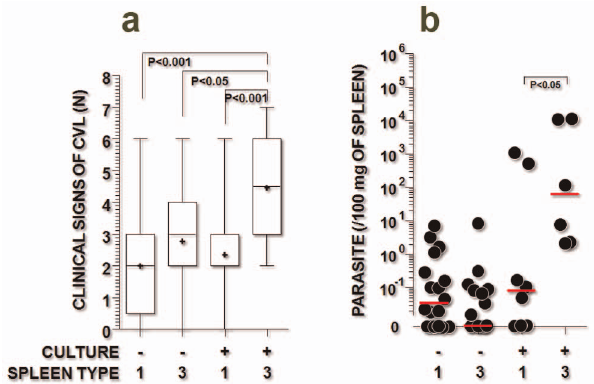
Figure 1. Clinical signs of visceral leishmaniasis and parasite burden in dogs naturally infected with Leishmaniainfantum and with different levels of disorganization of the splenic white pulp. a) frequency of clinical signs associated with visceral leishman- iasis (alopecia, anemia, conjunctivitis, dermatitis, emaciation, lymph- adenopathy, and onychogryphosis); b) parasite burden in the spleen, as estimated by qPCR (see details in the text). The spleen types include spleen type 1 (organized), type 2 (slightly disorganized), and type 3 (moderately to severely disorganized). The Kruskal-Wallis statistical test was used.